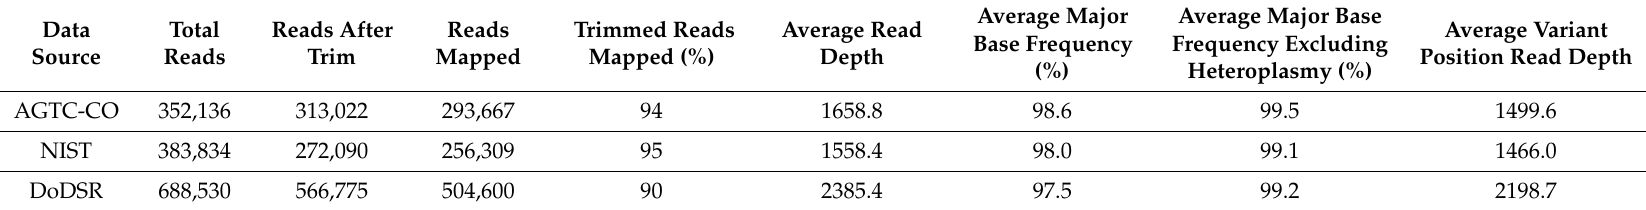
Table 4. Analysis metrics for each data source. The metric values from each set were